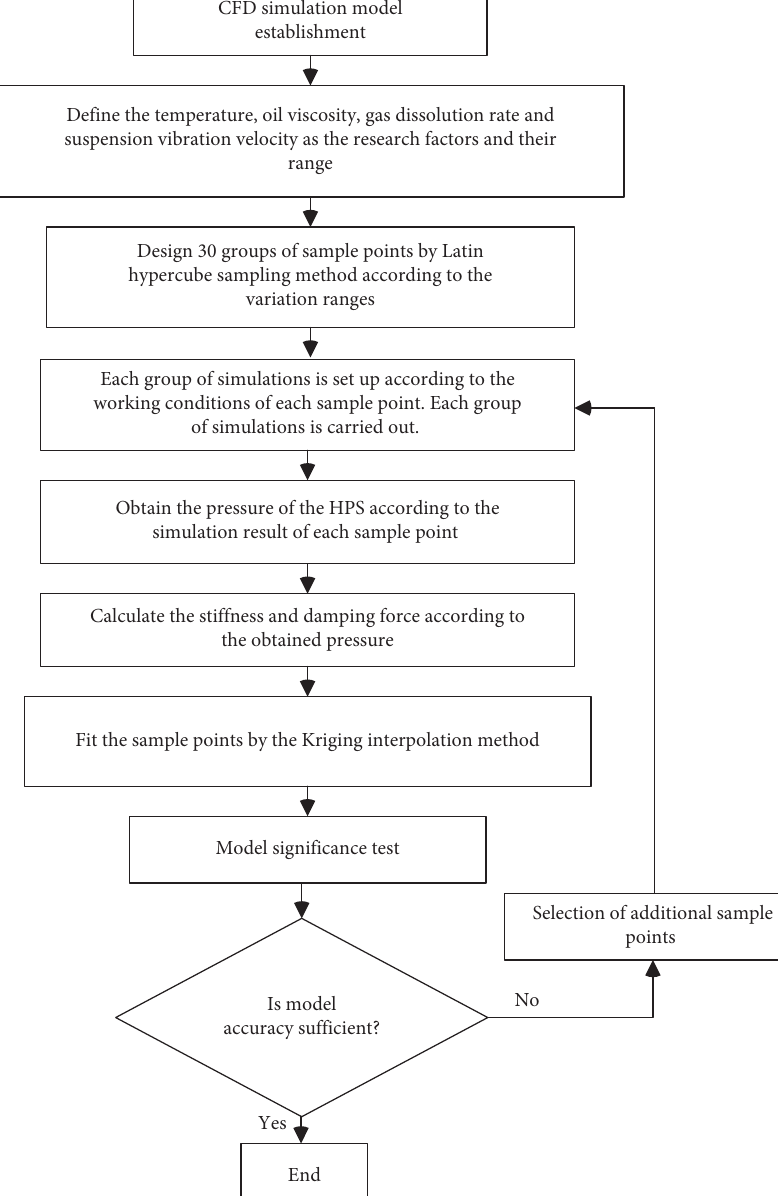
Figure 12: Flowchart of the HPS modeling